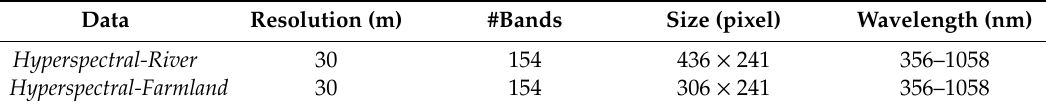
Table 2. Description of hyperspectral datasets (italic characters are the name of datasets).